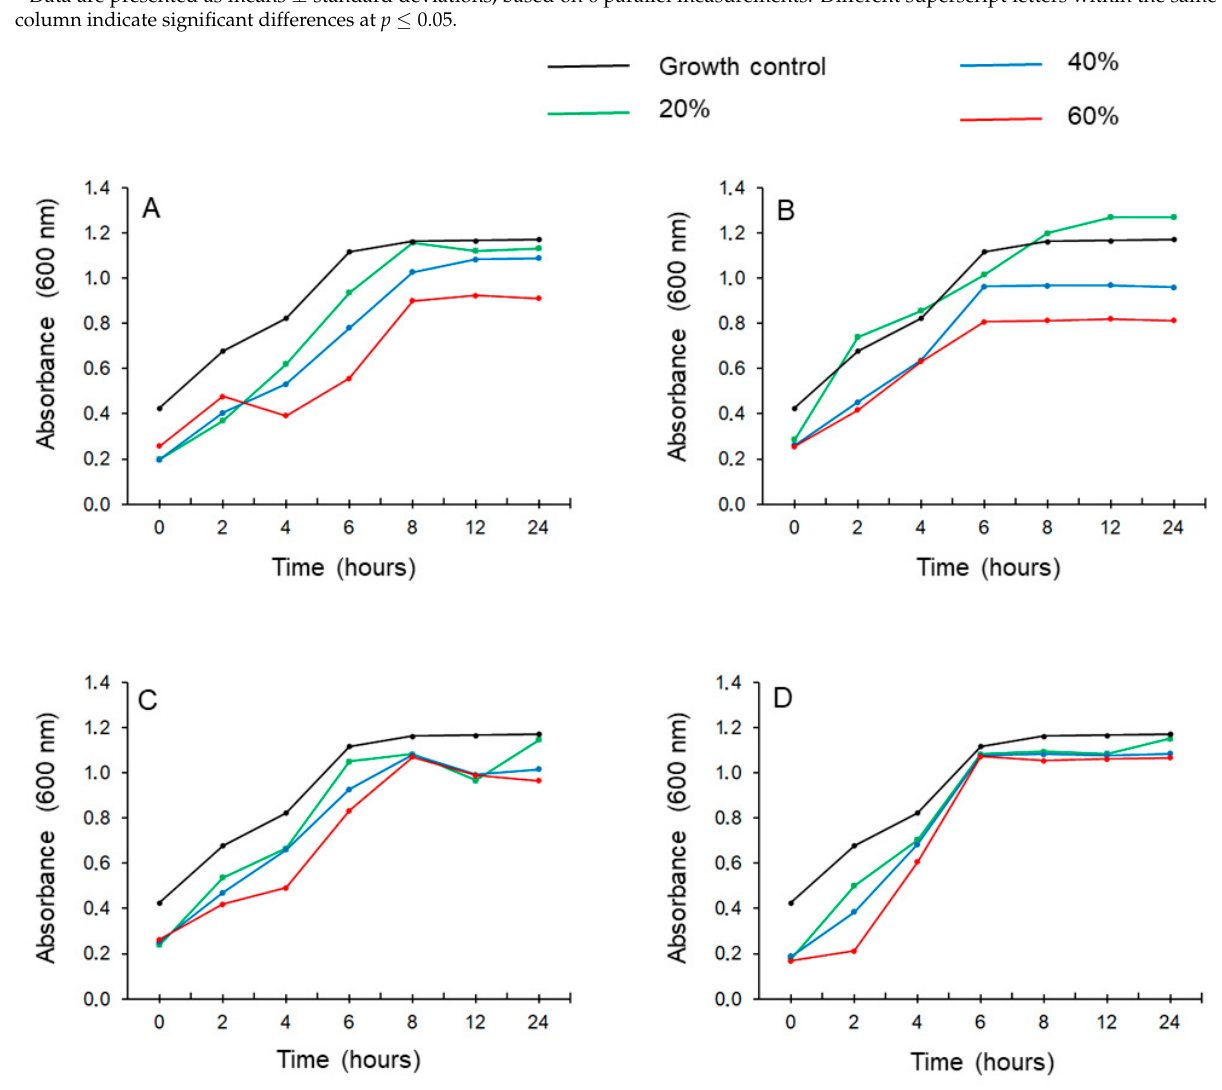
Figure 4. Time-kill assay in case of P. aeruginosa: ( A ) black locust honey samples, ( B ) linden honey samples, ( C ) sunflower honey samples, and ( D ) sugar (glucose:fructose, 1:1) solutions.